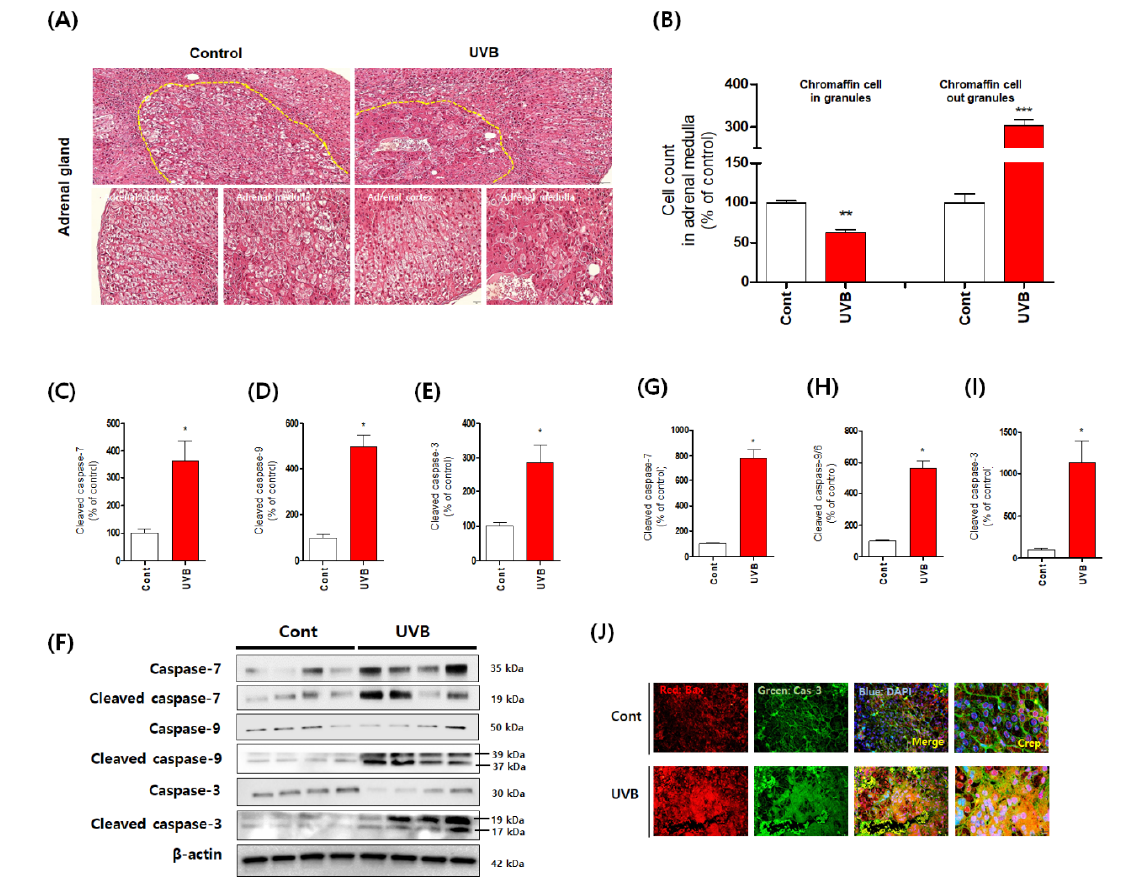
Figure 2. Accelerated cytotoxicity and augmented apoptosis signaling in chromaffin cells of the adrenal medulla induced by mouse skin exposure to chronic excessive UVB irradiation. ( A ) Representative histological analysis of an adrenal gland section damaged by the exposure to UVB. ( B ) Hematoxylin/eosin staining was used to identify chromaffin cell counts in granules. ( C – E ) Western blotting analysis of the apoptosis markers cleaved caspase-7 ( C ), cleaved caspase-9 ( D ), and cleaved caspase-3 ( E ). ( F ) Representative western blot images are shown. ( G – I ) The levels of cleaved caspase-7 ( G ), cleaved caspase-9/6 ( H ), and cleaved caspase-3 ( I ) were determined by ELISA. ( J ) Expression levels of Bax and cleaved caspase-3 were confirmed by using immunohistochemistry. Values represent the mean ± standard error of the mean. Statistical significance of differences is illustrated as follows: * p < 0.05, ** p < 0.01, and *** p < 0.001 compared with the control group.